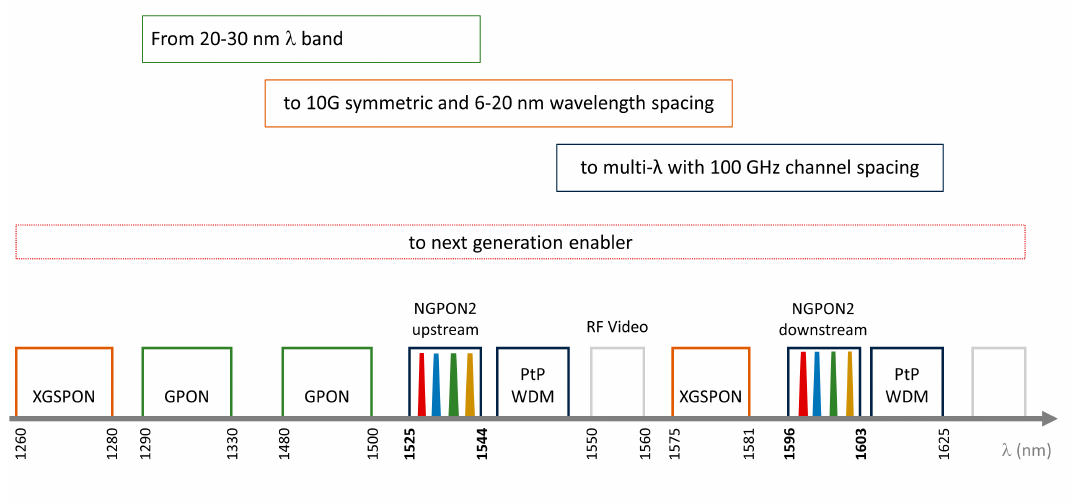
Figure 5. Spectrum allocation in ITU-T based standards for PON and trends for channel spacing.